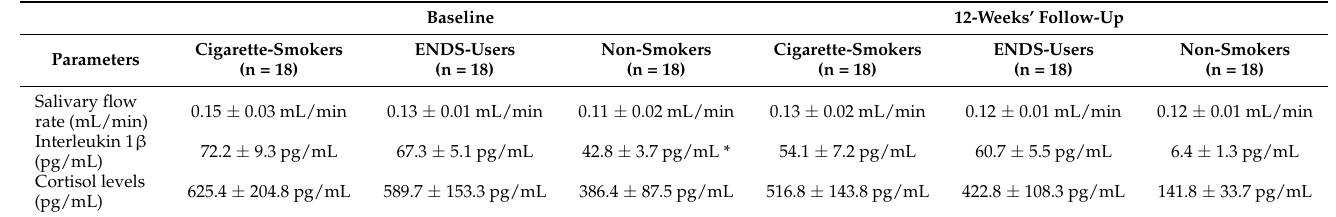
Table 3. Whole salivary flow rate and cortisol and interleukin 1-beta levels at baseline and at 12 weeks of